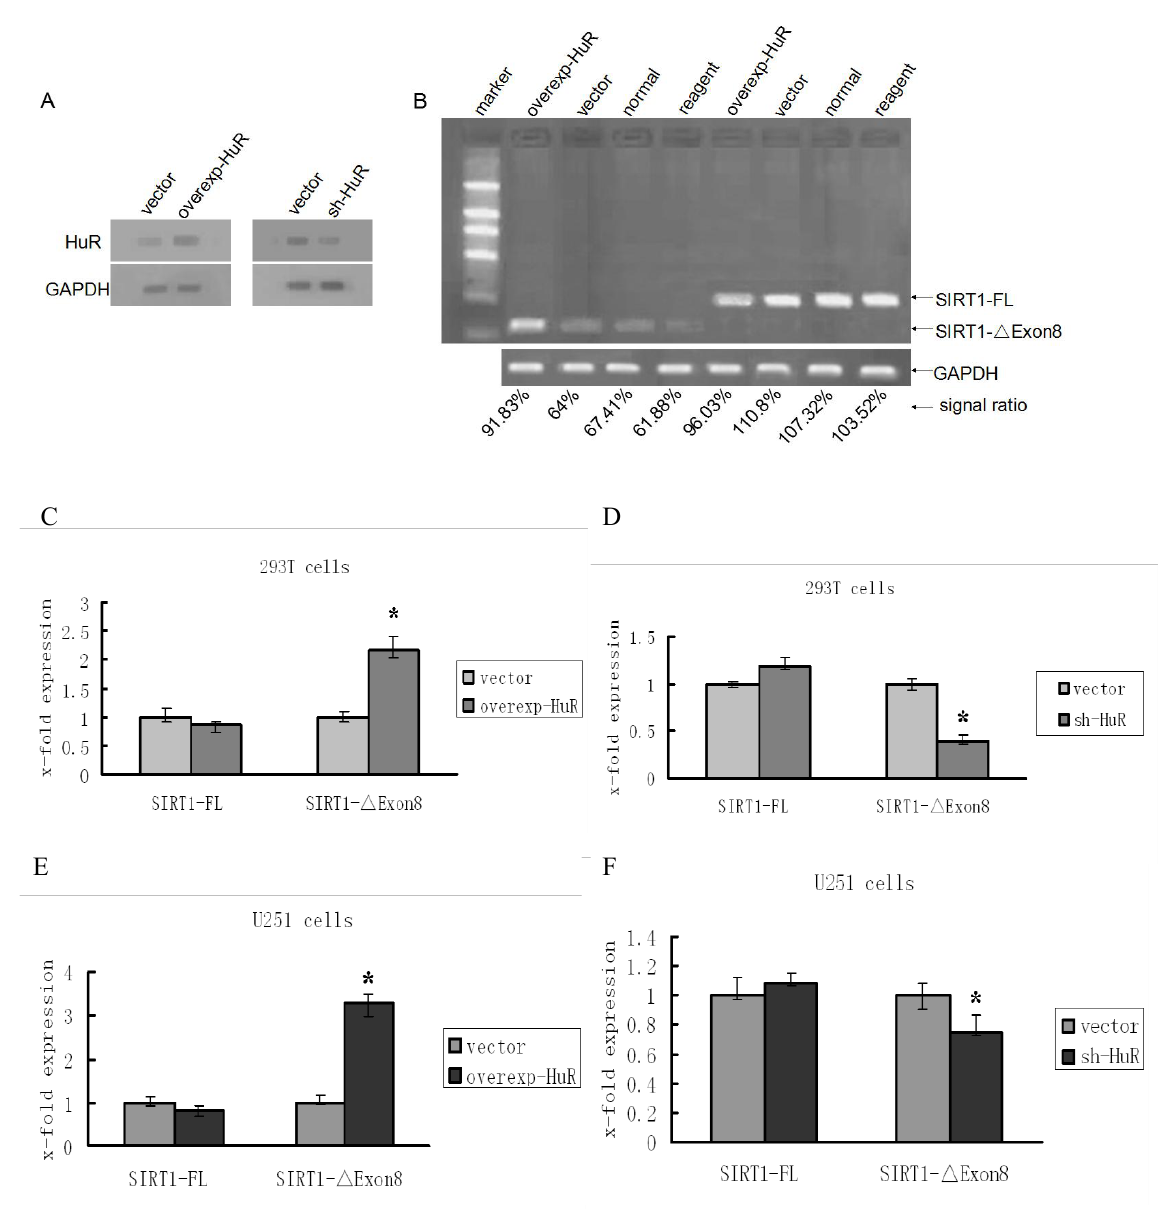
Figure 1. HuR regulates the SIRT1-∆Exon8 mRNA levels in 293T cells and U251 cells. ( A ) The changes of HuR protein levels after HuR overexpression or silencing in 293T cells; ( B ) PCR products were separated in 1% agarose gels, the arrows point at the location